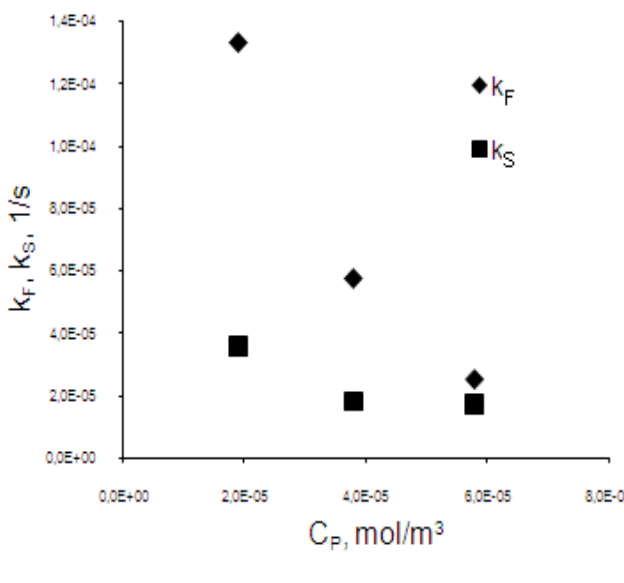
Figure 7. Variation of: (a) the pseudo-first-order apparent membrane entrance (k (k ) rate constants and, (b) the entrance (J S concentration in the feed phase for membrane flow velocity w = 0.0034 m·s -1